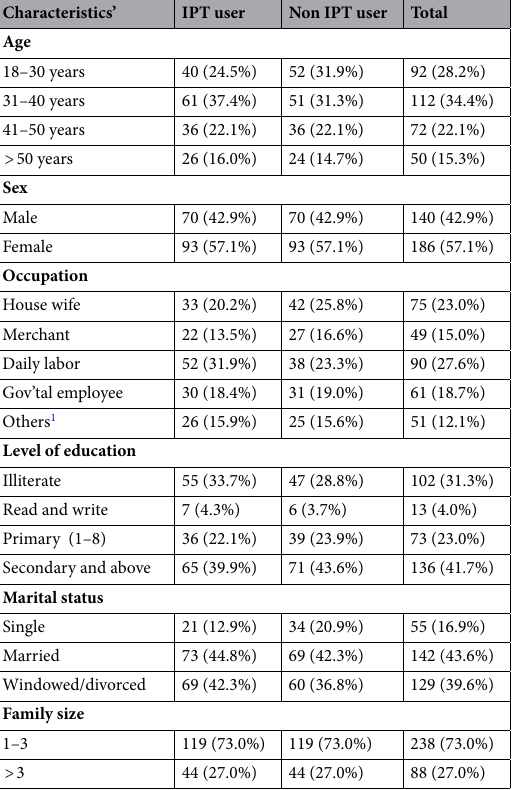
Factors associated with TB among non‑IPT and IPT users of HIV patients. In bivariable logistic regression analysis, variables such as sex, CD4 count, ART adherence, IPT use, and BMI less than 18.5 kg/m 2 ,